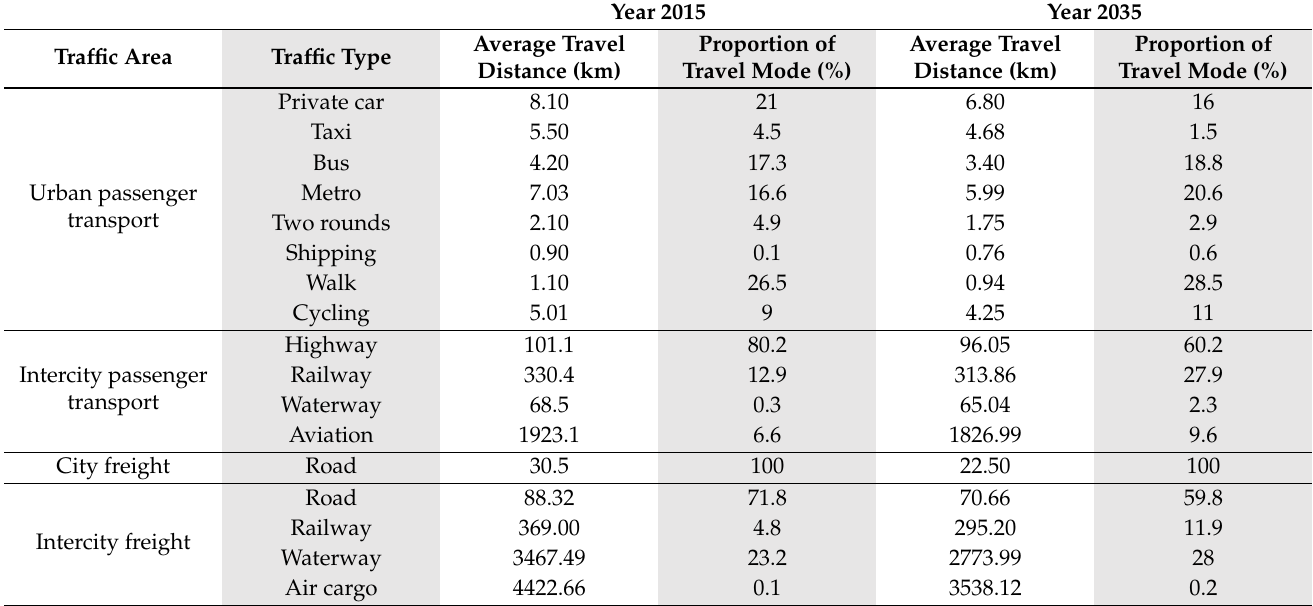
Table A5. Traffic mode scenario